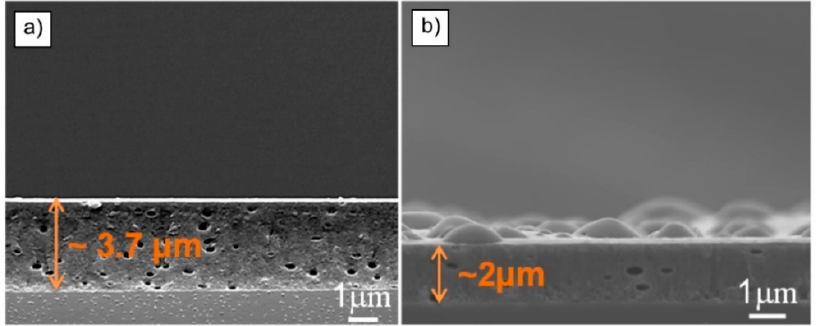
Figure 11. SEM cross-sectional images of hydrophobic coating B (deposited by solution processing), ( a ) as-deposited, and ( b ) after 1000 h of DH exposure. The thickness was substantially reduced.